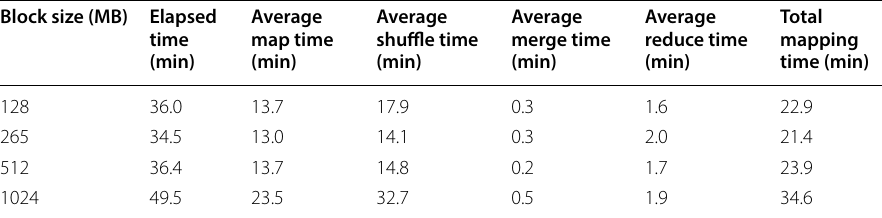
Table 5 Clustering (17.79 GB) raster image using a 50 nodes Hadoop-cluster Block size (MB) Elapsed time